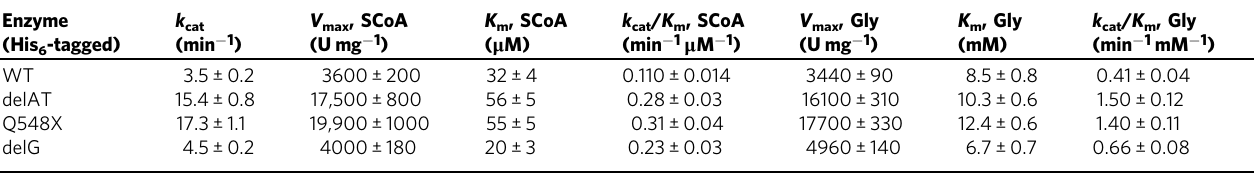
Table 3 Steady-state kinetics of recombinant hsALAS2 XLP variants. Enzyme (His 6